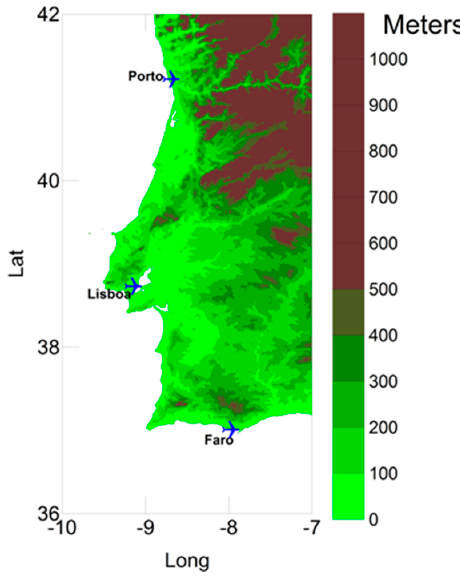
Figure 1. Location of the Portuguese international airports.